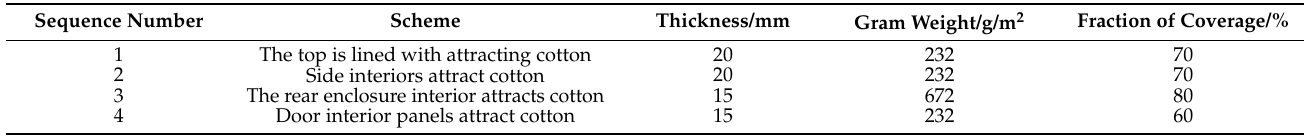
Figure 16. Simulation of an acoustic enclosure covering an area of the cab. ( a ) Simulation of acoustic coverage of cab side; ( b ) Simulation of acoustic coverage of cab rear; ( c ) Simulation of acoustic coverage of cab floor. Table 10. Acoustic optimization scheme for the